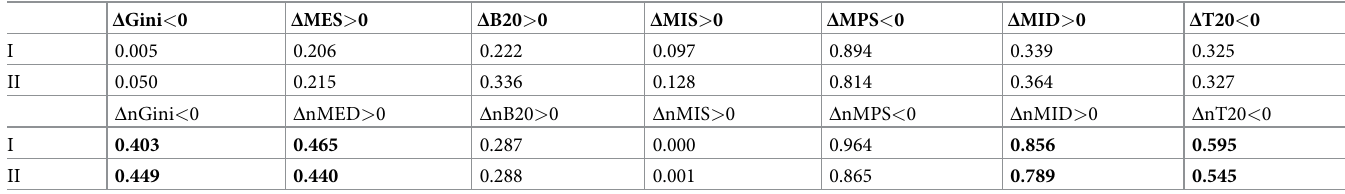
Table 18. Simulation